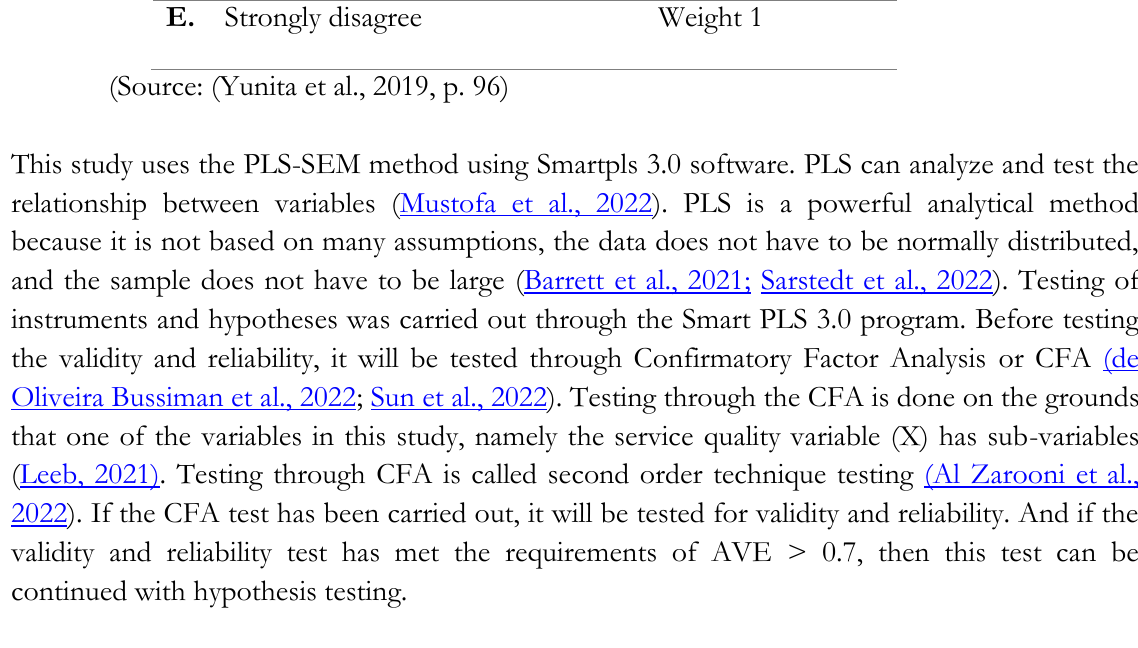
Table 2. Respondent